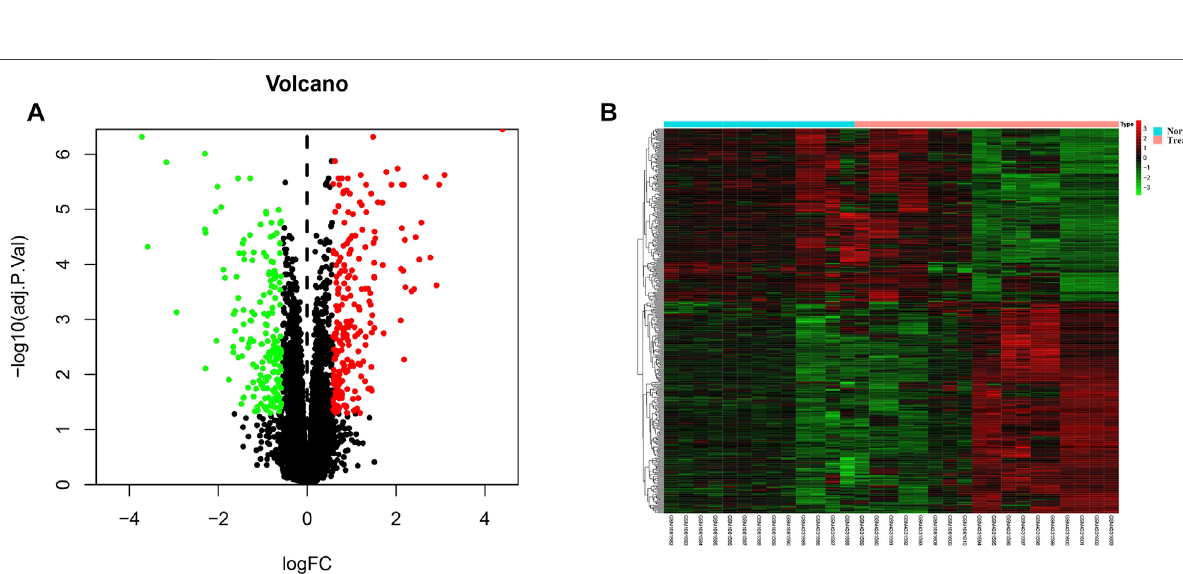
FIGURE 3 | Identi fi cation of differentially expressed genes. (A) Volcano plot for all genes, the green dot represent the down-regulated genes, red dot indicated the up-regulated genes, while the black genes showed the non-signi fi cant genes. (B) The differentially expression genes were plotted by a heatmap, the bright red bar indicated the higher gene expression level, while the bright green indicated the lower gene expression